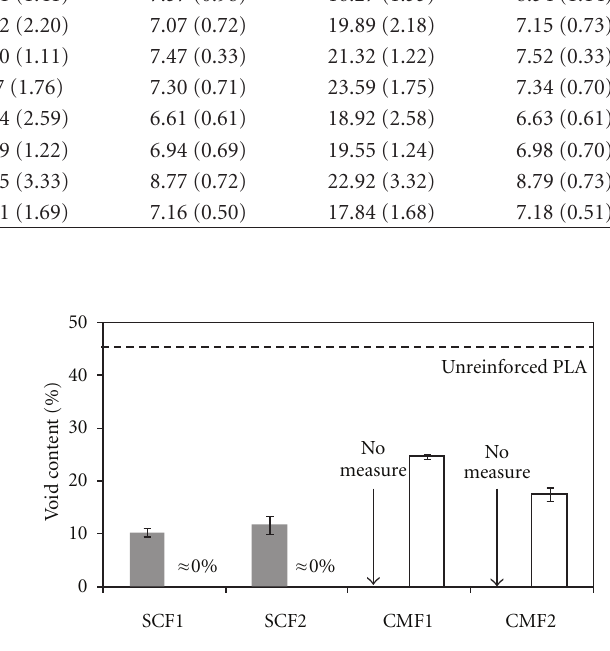
Figure 6: Void fraction of cellulose reinforced PLA foams as a function the fibre content: (cid:2) 20 wt%; (cid:3) 30wt% (PLA7000D, 3wt% CBA2 for biocomposites foams, 4wt% CBA2 for PLA foam, temperature profile A, screw speed 30rpm, die temperature 195 ◦ C, free